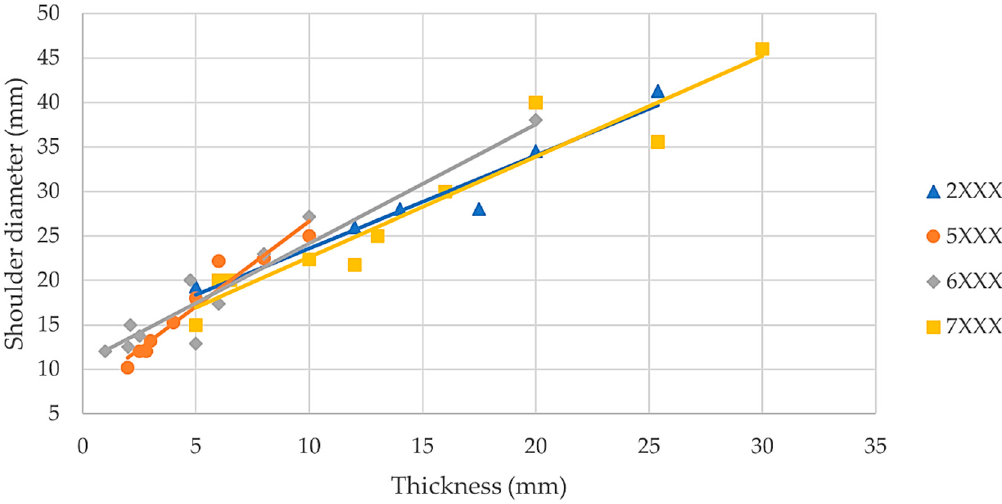
Figure 8. Summary of trend lines for shoulder diameter vs. thickness.